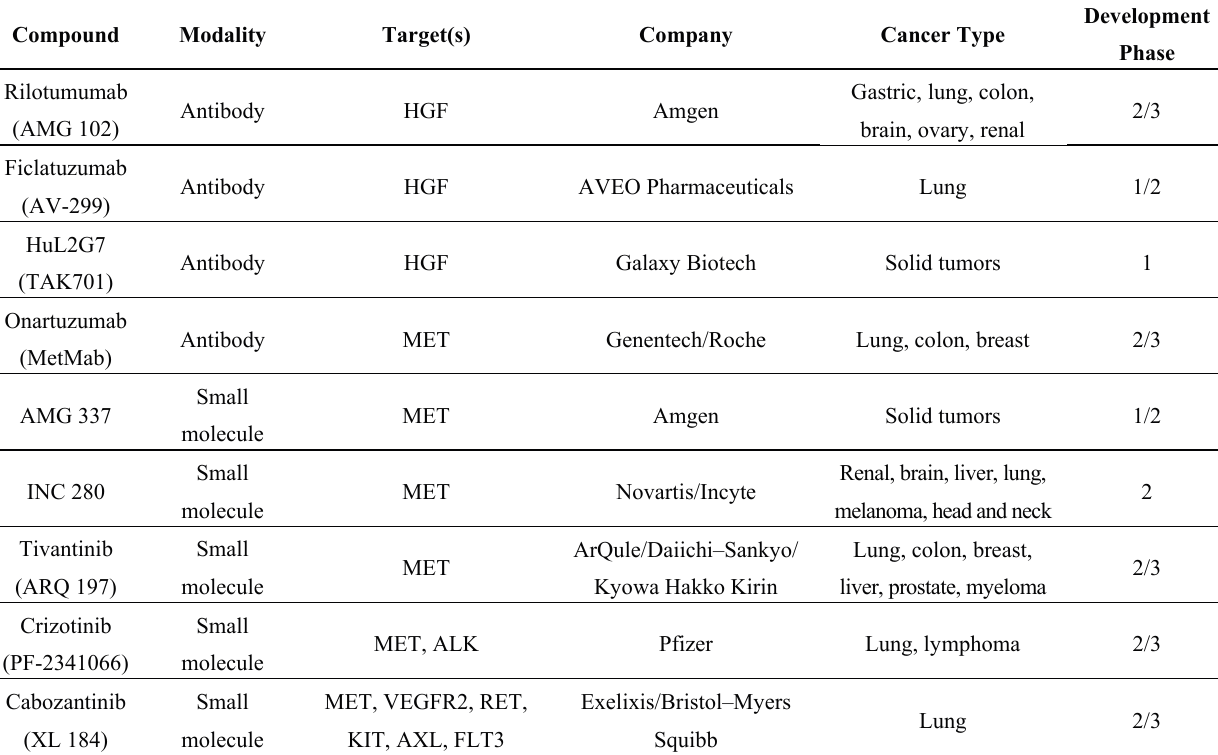
Table 1. HGF/MET inhibitors in clinical